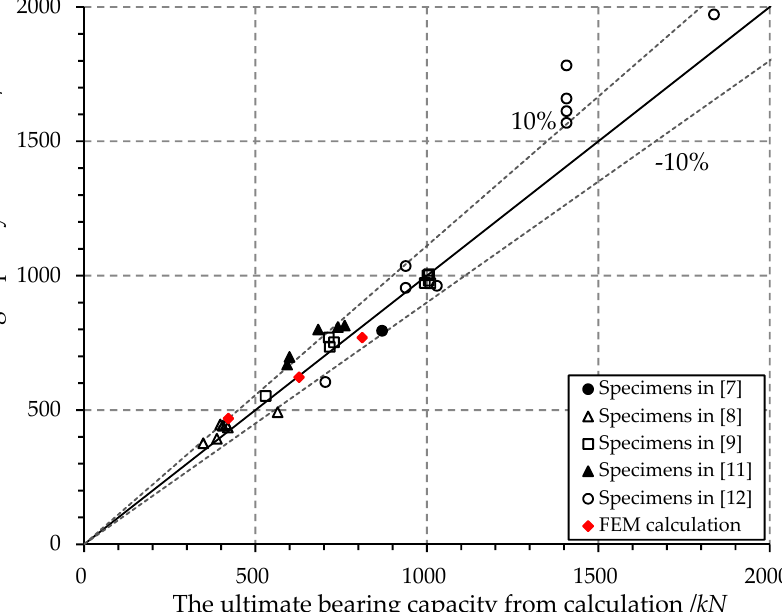
Figure 12. Comparison between test results and calculated results of specimens in the existing literature.